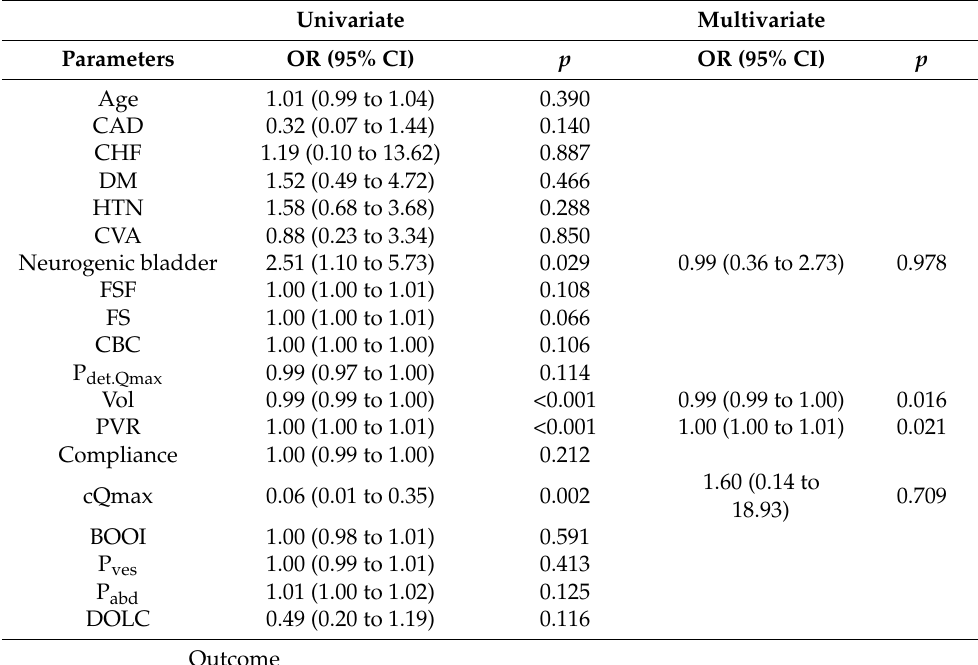
Table 3. The univariate and multivariate analysis of predictor factors associated with success rate. Univariate